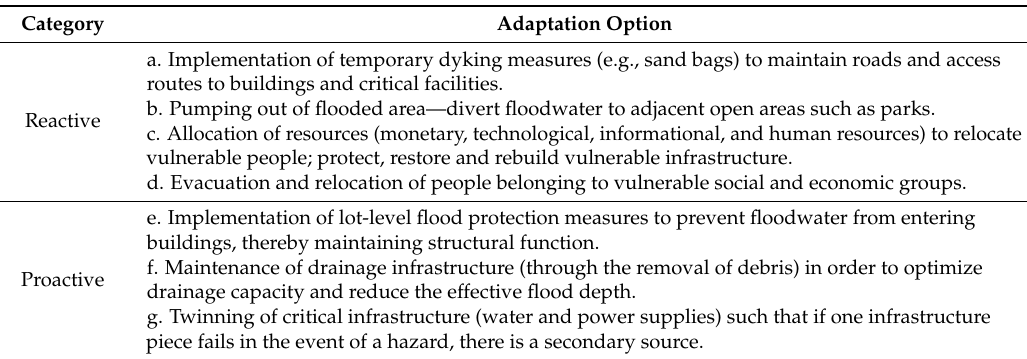
Table 2. Adaptation options available on